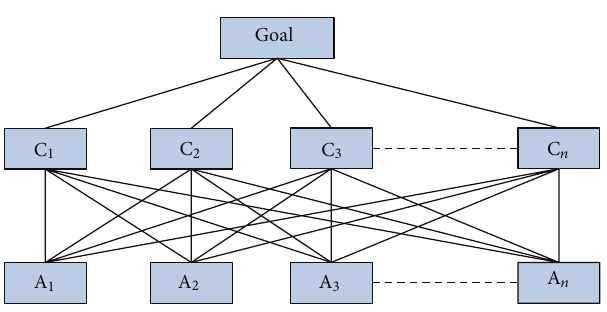
Figure 1: Main structure of AHP in terms of goal, criteria, and alternative.